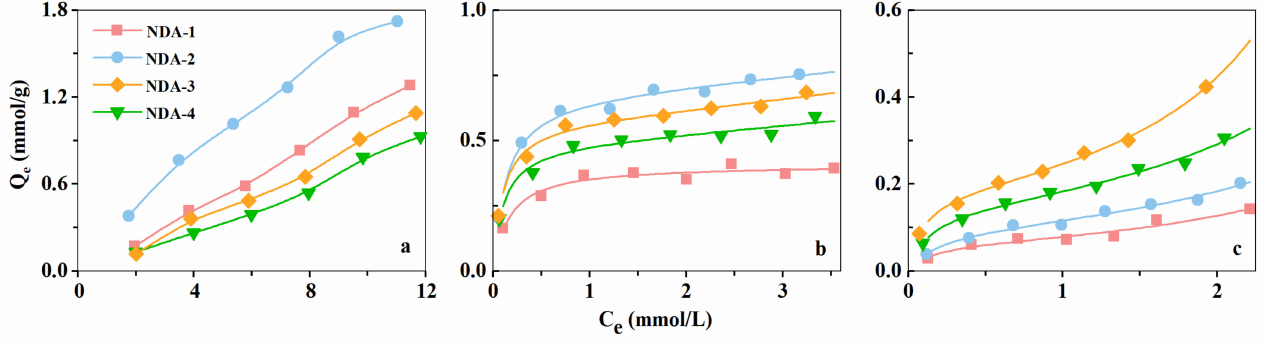
Figure 6. ( a ) Adsorption isotherms of phenol; ( b ) Adsorption isotherms of ABS acid; ( c ) Adsorption isotherms of